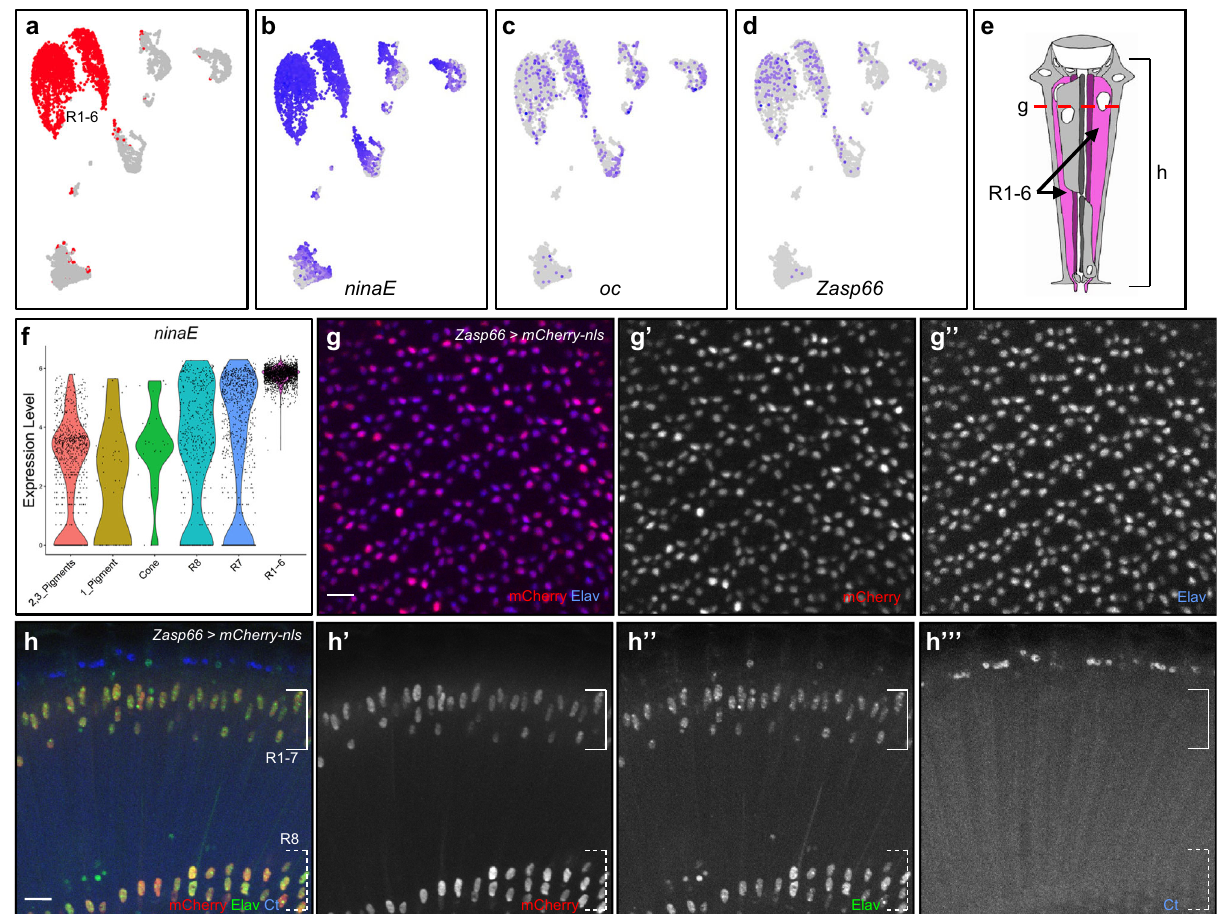
Fig. 3 R1-6 photoreceptor cluster identi fi cation and Zasp66 is a novel marker for adult photoreceptor cells. a R1-6 cell clusters in Seurat UMAP cluster plots of 7-day-old adult eyes are colored red. b – d FeaturePlots showing gene expression of ninaE ( b ) , oc ( c ), and Zasp66 ( d ). All cells expressing oc and Zasp66 were brought to the front in FeaturePlots ( c ), ( d ). e Schematic of an ommatidium where the bracket and red dotted line mark the focal plane of the views in ( g ) and ( h ), respectively. f ViolinPlot of log-normalized ninaE expression in all cell types. g Tangential view of a 7-day-old Zasp66-T2A-Gal4 > UAS- mCherry-nls adult eye costained with mCherry and Elav in red and blue, respectively. h Coronal view of 7-day-old Zasp66-T2A-Gal4 > UAS-mCherry-nls adult eye costained with Elav and Ct. Solid white bracket marks the R1-7 nuclei and dashed white bracket marks R8 nuclei. Scale bars: 10 μ